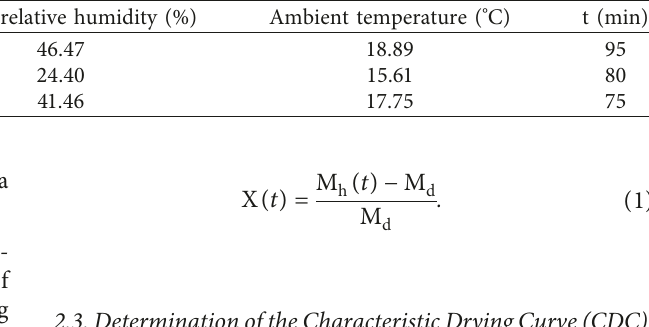
Figure 1: Schematic of the solar dryer used in the experiment: (1) solar collector; (2) circulation fan; (3) fan; (4) airflow direction; (5) control box; (6) auxiliary heating system; (7) shelves; (8) drying cabinet; (9) air recycling; (10) control foot; (11) exit of air; (12) humidity probes; (13) thermocouples; (14) sample holder. Table 1: Drying parameters and conditions during experiments in the solar